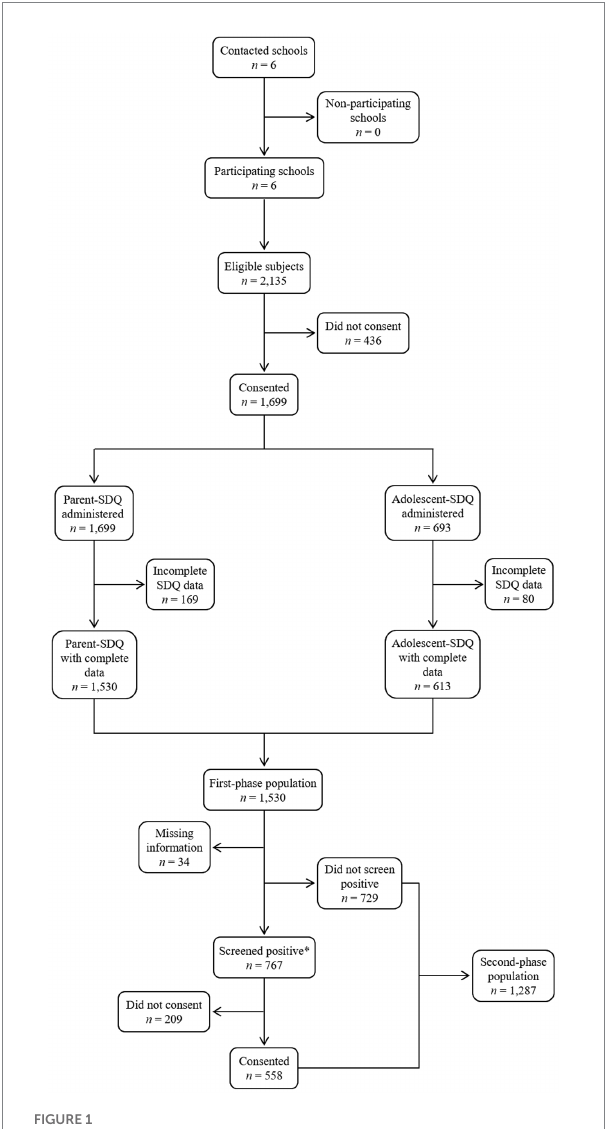
FIGURE 1 Flowchart of the study design and data collection process. * Cases were defined according to: a score in the clinical range on any of the parent-reported SDQ problem scales; five or more high-risk indicators on the PRODISCAT; or a previous diagnosis of neurodevelopmental disorder from a medical